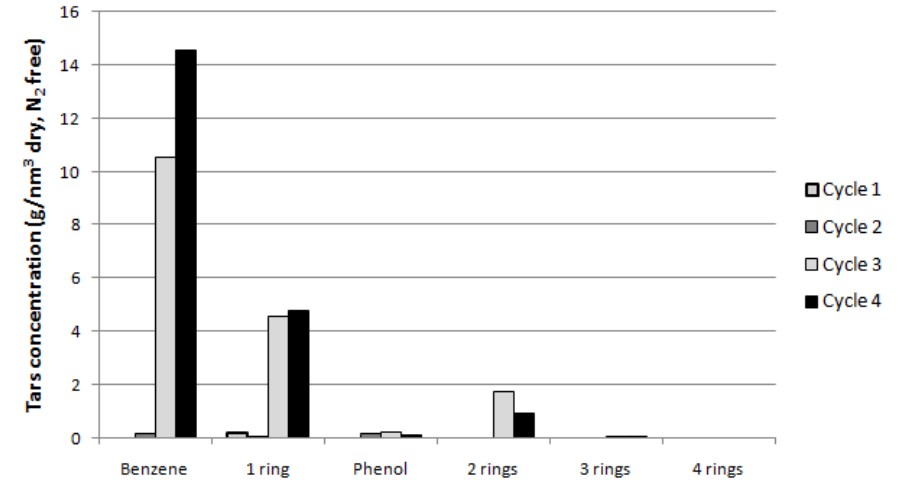
free) for single TAR classes during the cycles. 2